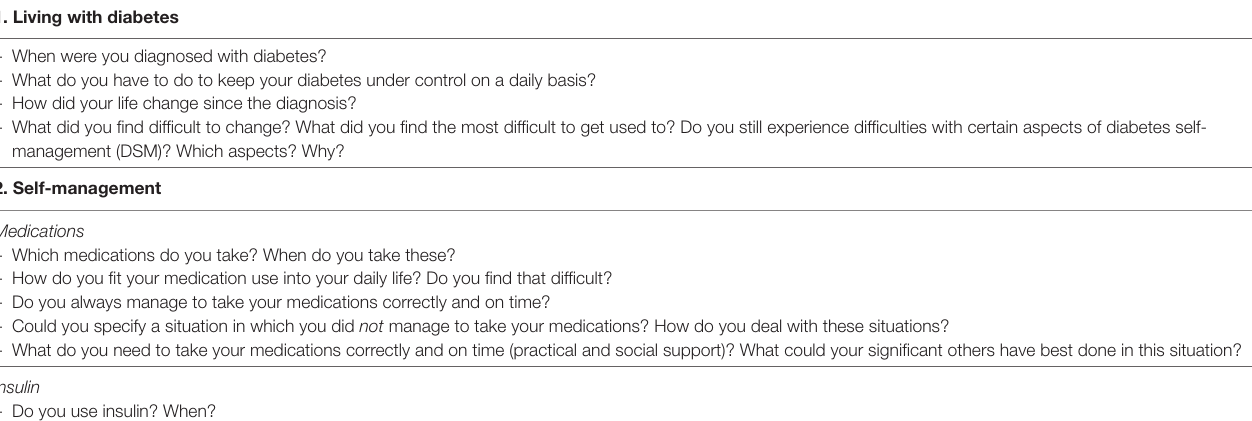
TaBle 1 | Topic list for patients from a socioeconomically deprived